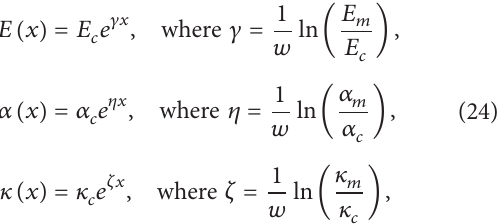
Table 1: Material properties of Rene-41 and ZrO 2 [6]. Property Young’s modulus 𝐸 , GPa 219.7 151 Mass density 𝜌 , kg/m 3 Poisson’s ratio